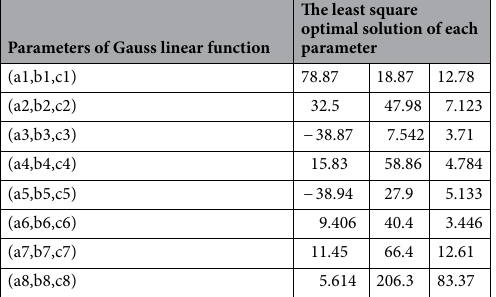
Parameters of Gauss linear